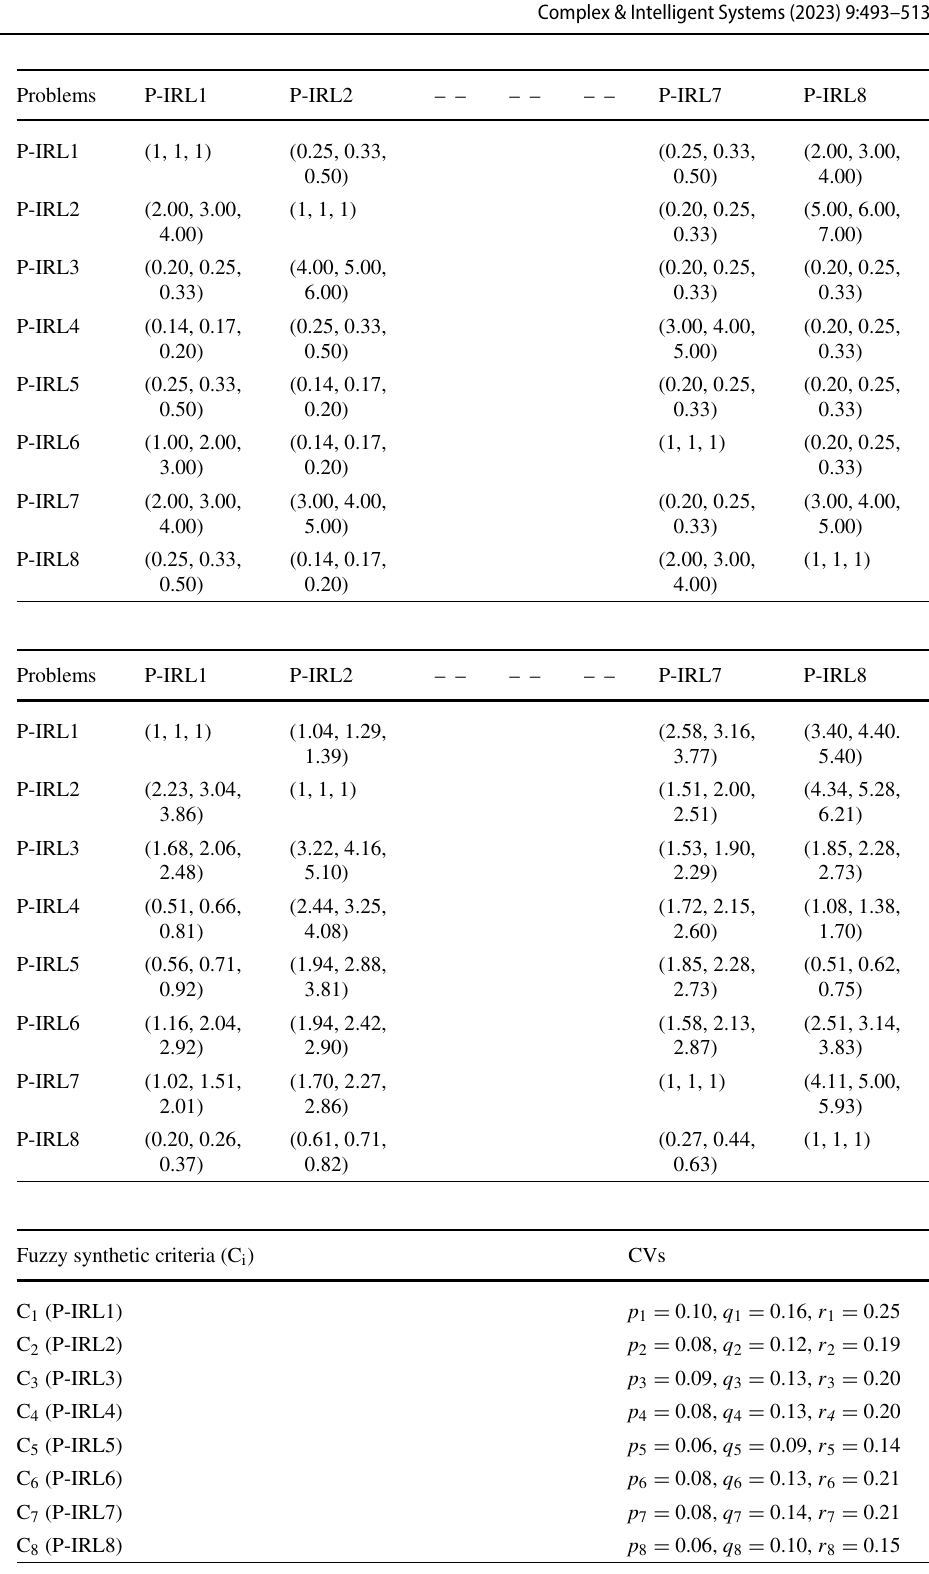
Table 4 TFN decision matrix for IRL problems